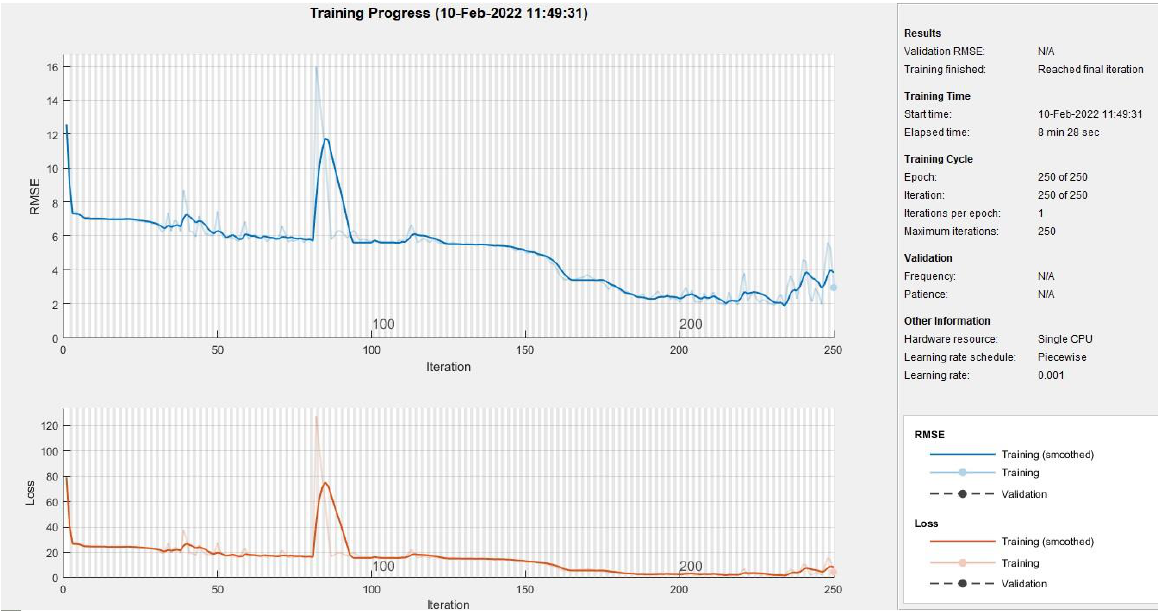
Figure 5. The attenuation levels derived from the training data compared to actual data. Reprinted with permission from ref. [1]. Copyright 2021 IEEE.